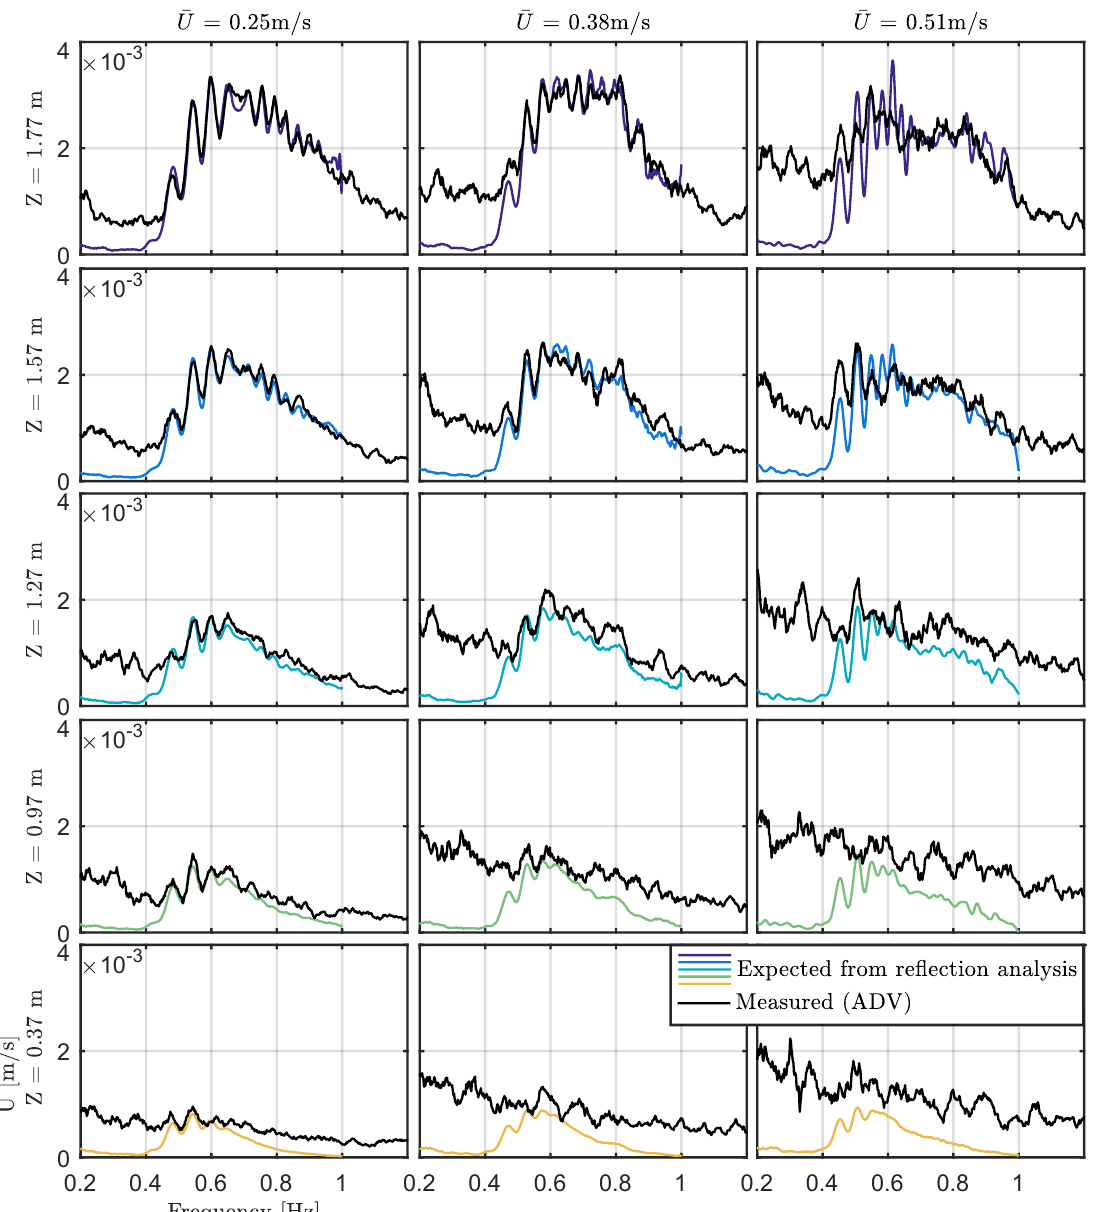
Figure 16. Measured horizontal velocity spectra compared with those expected from theory. Shown for irregular wave cases (Sea States 5–7, Table 3) for each of the five ADV